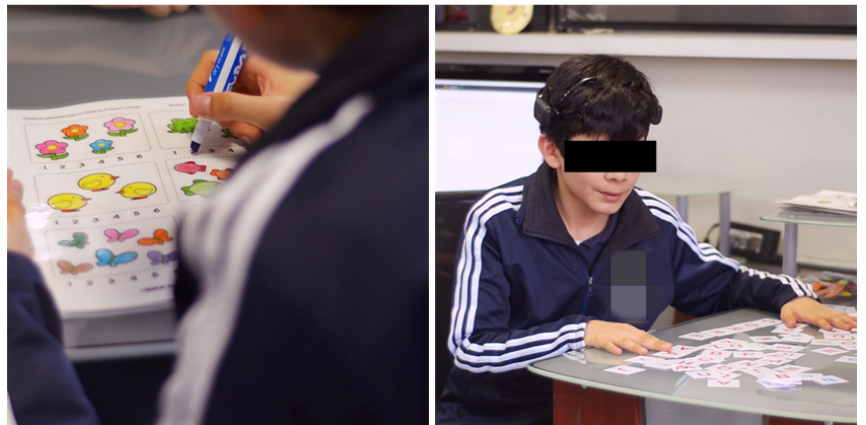
Figure 2. Data acquisition process with the Emotiv Epoc+. The EEG recordings start once the localization of the headset is correct, and the signal quality, and the electrode contacts are verified and in green level. Pictures are from http://imagentv.uabc.mx/videos/electro-encefalograf%C3%ADas- y-autismo-uabc-no-se-detiene-imago, accessed on 29 December 2021.